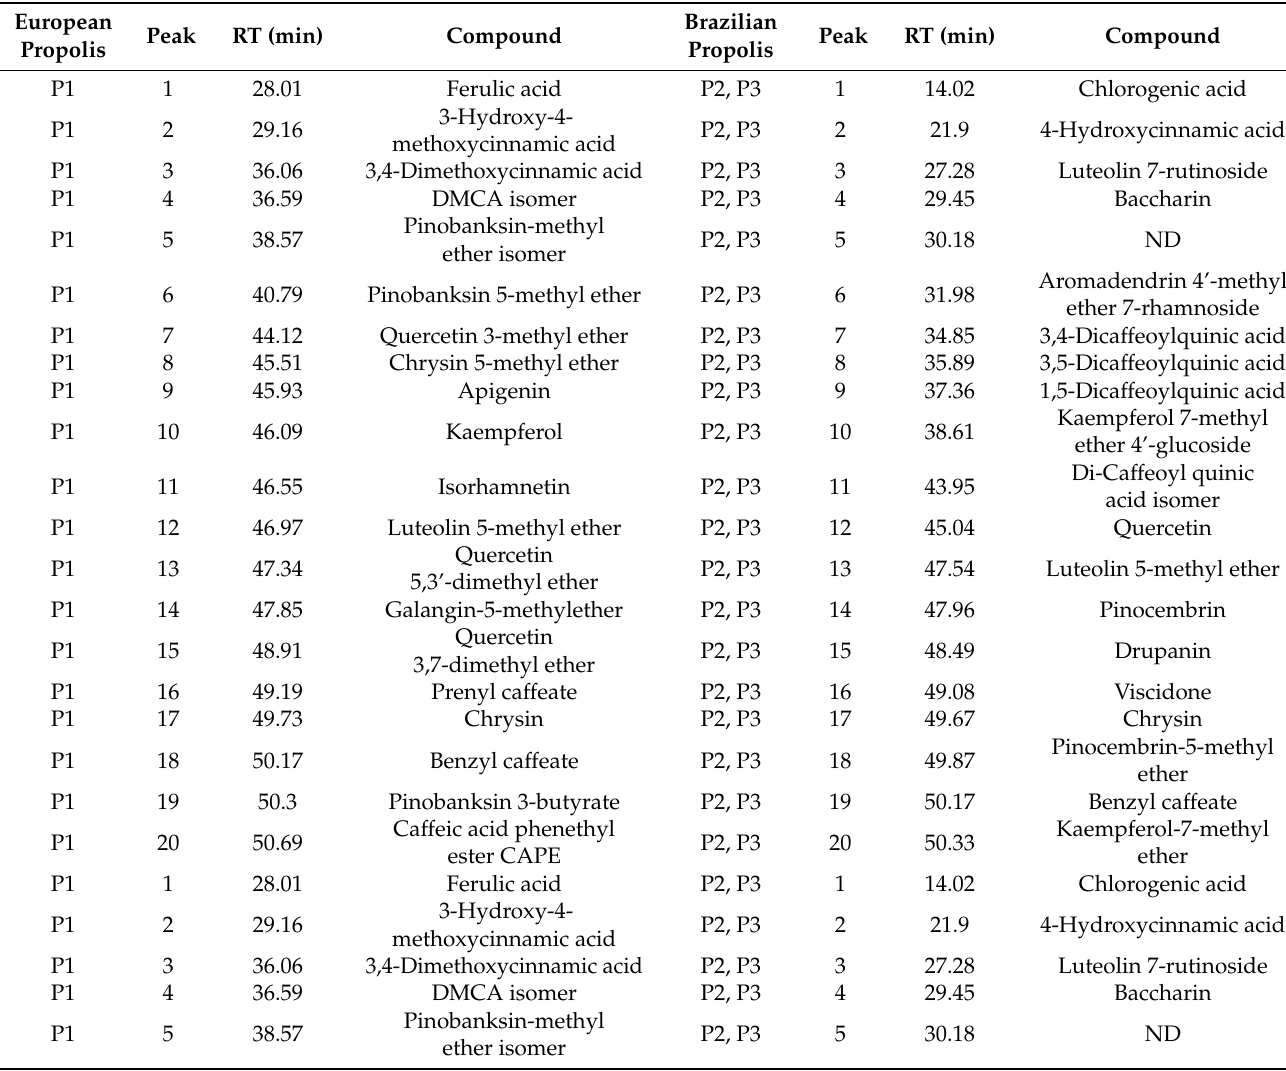
Table 2. Chemical analyses of the ethanolic extracts of